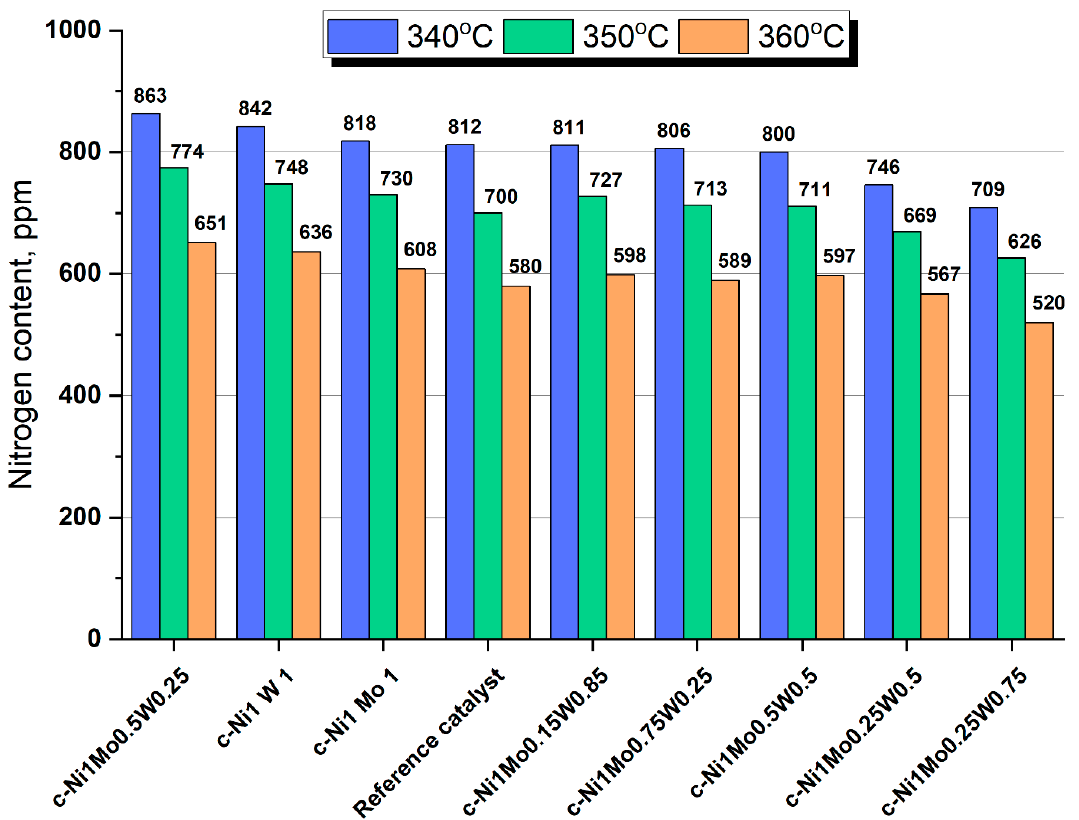
Figure 10. Residual nitrogen content in hydrotreated products for bulk c—Ni 1 Mo x W y sulfide catalyst and the reference supported sample.